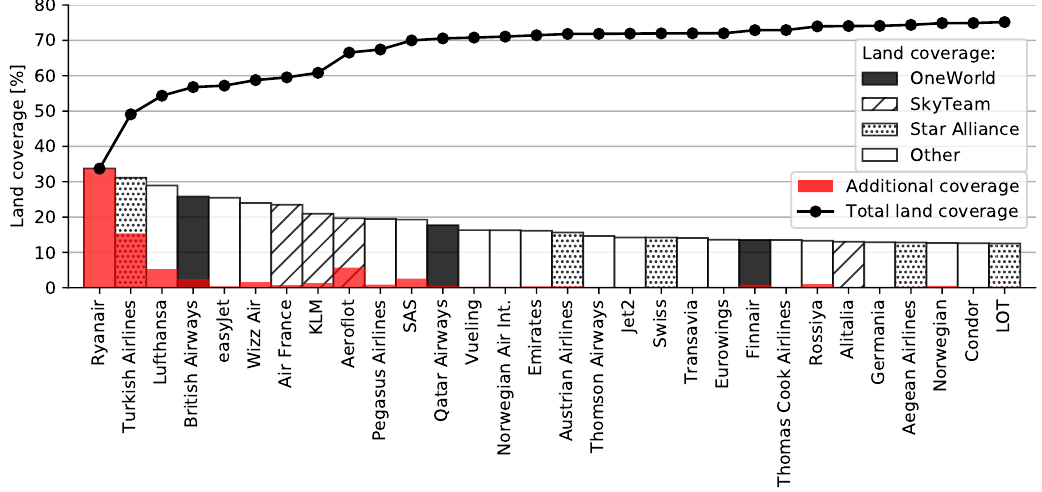
Figure 11. Cumulative land coverage by top 30 airlines with Imperx